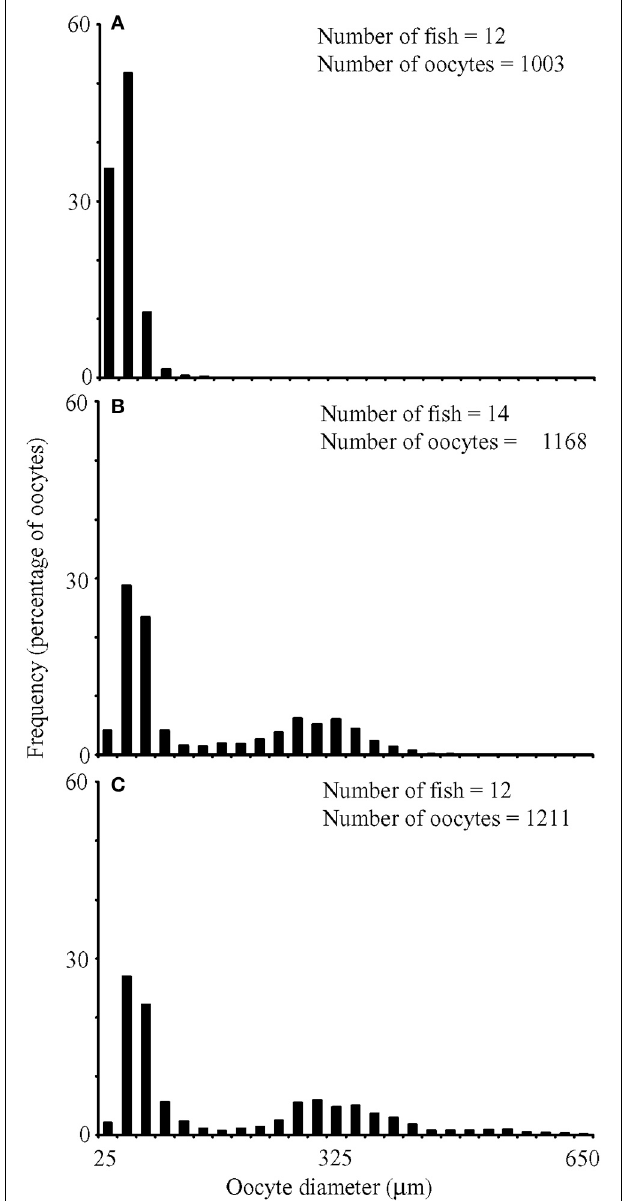
FIGURE 4 | Size frequency distributions for oocyte diameters from fish whose most advanced development stage was (A) primary growth, (B) secondary growth, and (C) maturation. Numbers of fish and oocytes examined included on